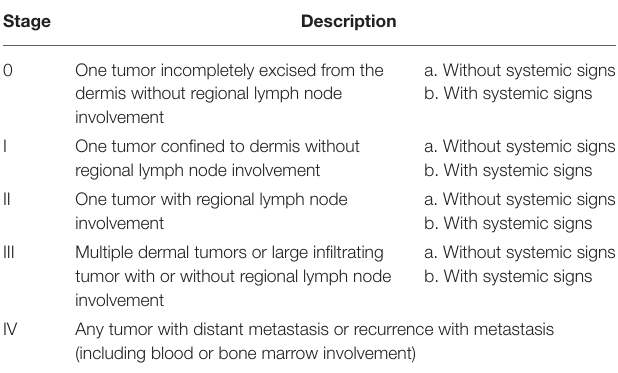
TABLE 1 | WHO clinical staging system for mast cell tumors